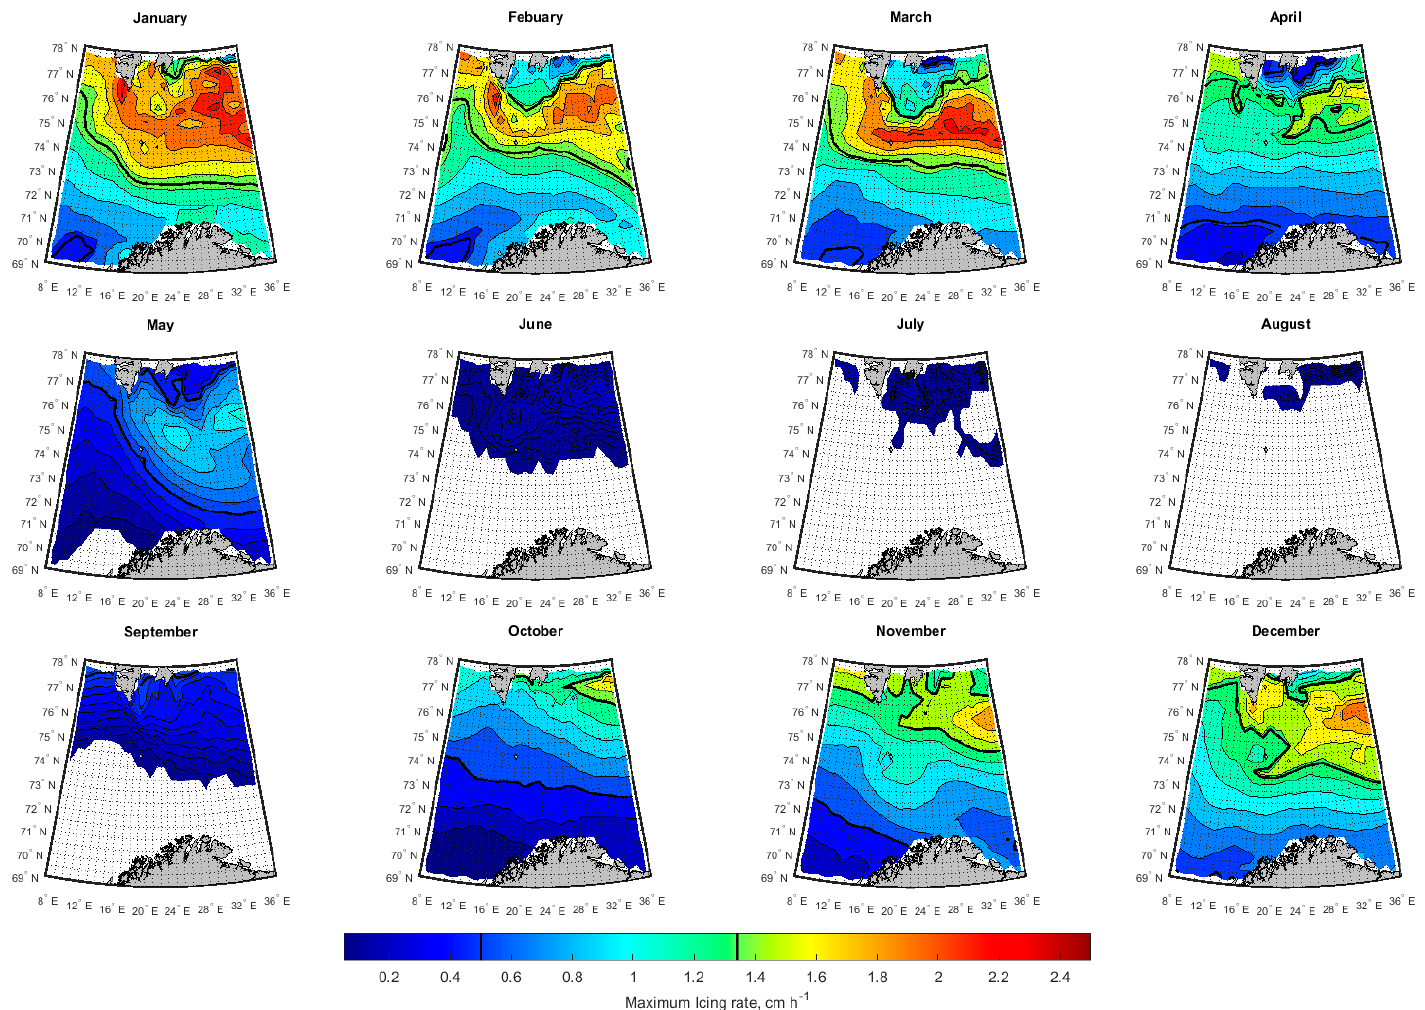
Figure 7. Maximum icing rate (all icing) in each month. The black lines illustrate the thresholds between light and moderate, and moderate and severe icing.